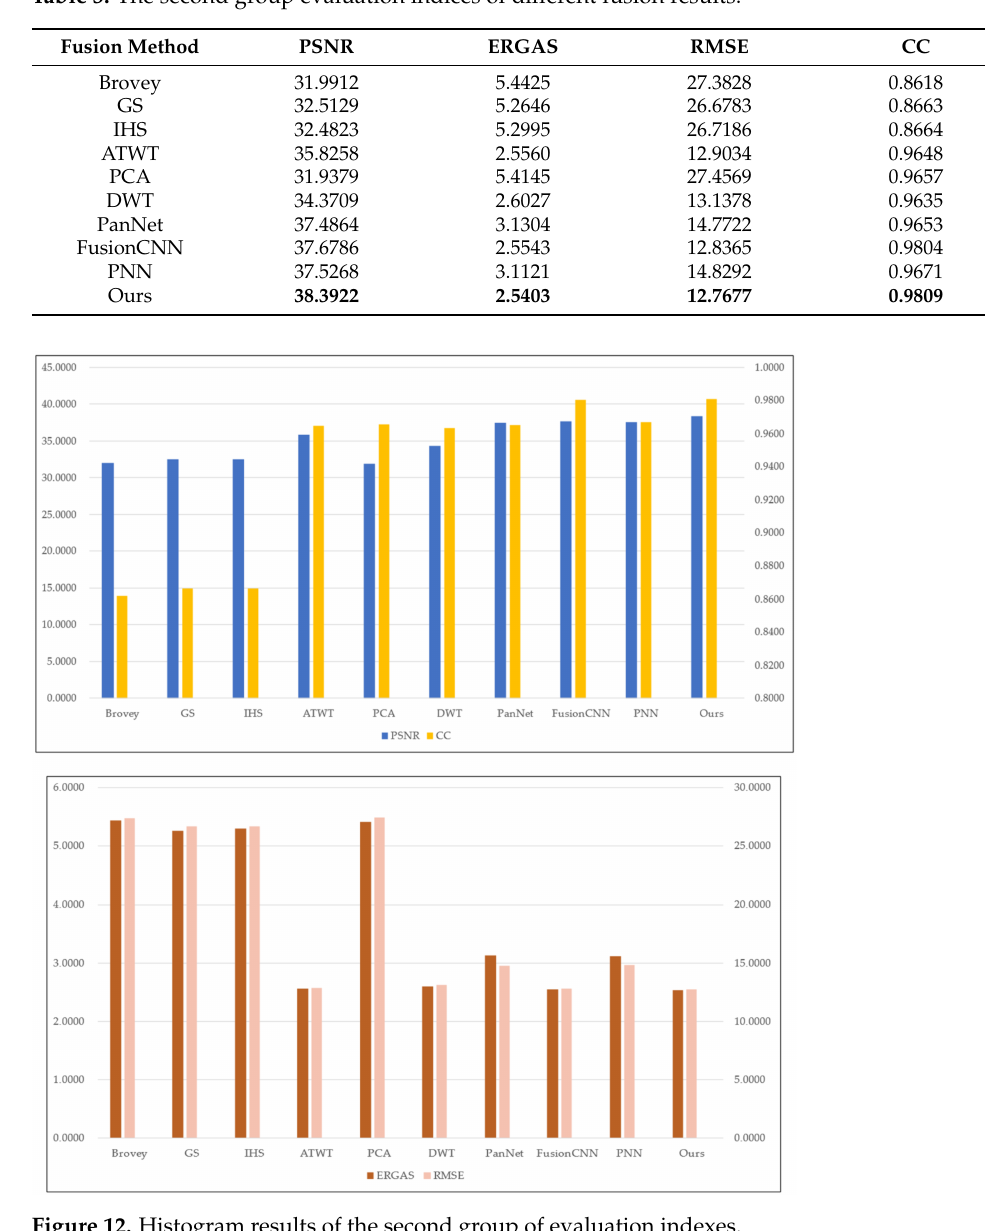
Figure 12. Histogram results of the second group of evaluation